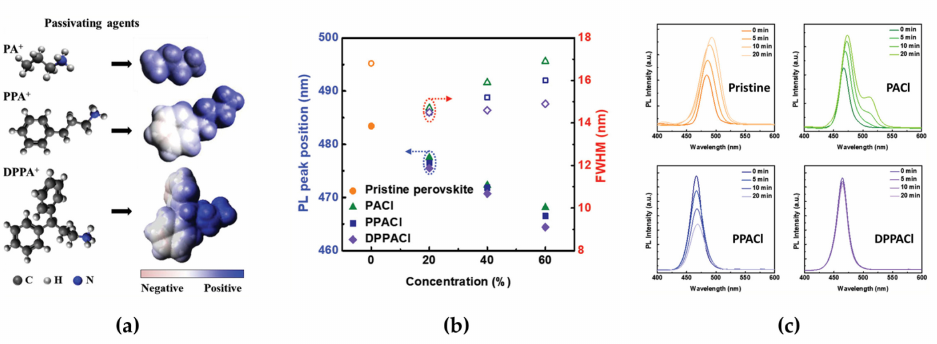
Figure 2. ( a ) Molecular structures and electrostatic potentials of PA + , PPA + , and DPPA + . ( b ) Photo- luminescence (PL) peak positions (left axis, filled symbols) and full width at half maximum (right axis, unfilled symbols) of perovskites as a function of the passivating agent concentration for the different passivating agents. ( c ) Steady-state PL spectra of pristine and 60% PACl, 60% PPACl, and 60% DPPACl perovskite films. Reprinted with permission from [45], Copyright 2020 John Wiley and